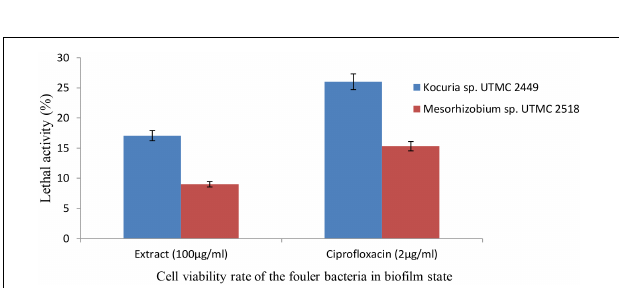
FIGURE 4 | Inhibitory effect of Glycomyces sp. UTMC 2460 extract on EPS production of fouling bacteria. Respective samples incorporated with “Diorun” (1 and 10 µ g ml − 1 ) serve as controls.